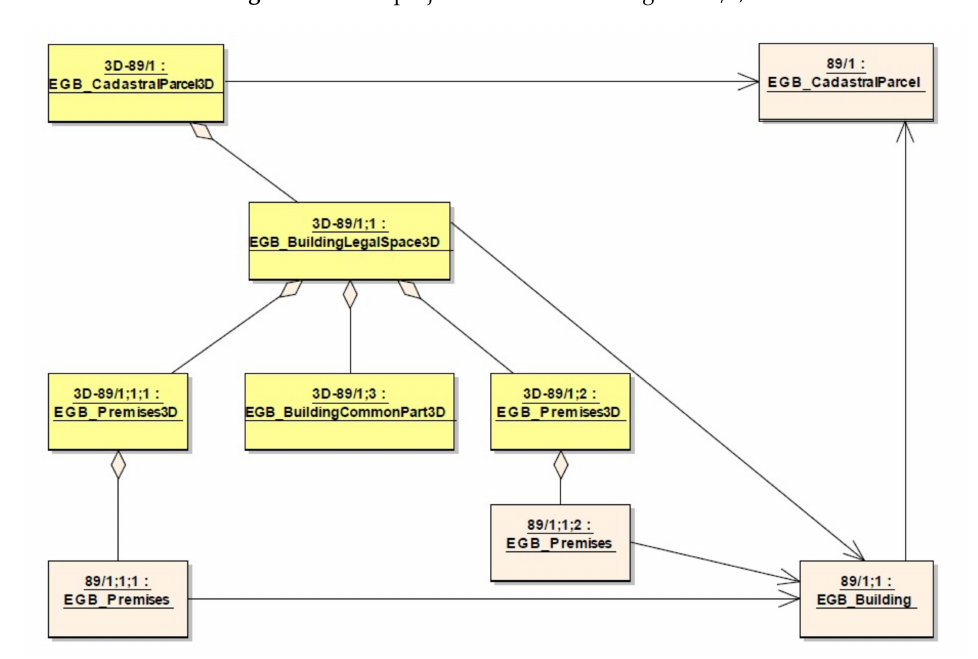
Figure 12. Floor projections of the building no. 89 / 1;1.